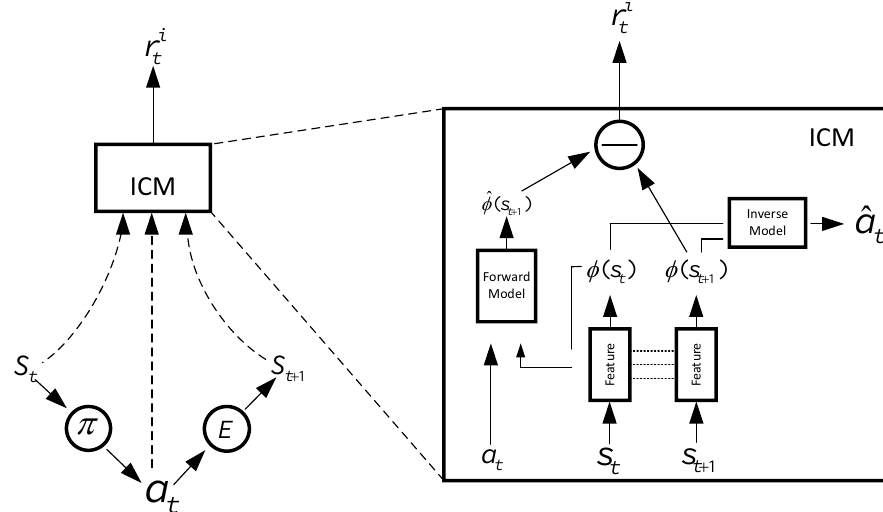
Figure 5. Curiosity reward evaluation mechanism.